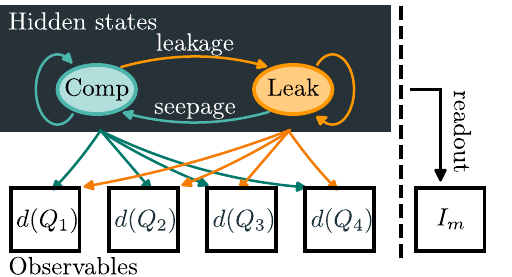
Fig. 4 Schematic representation of an HMM for leakage detec- tion. For both ancilla and data qubits only two hidden states are considered, corresponding to the qubit being either in the computational (teal) or leakage subspace (orange). Transitions between these states occur each QEC cycle, depending on the leakage and seepage probabilities. The state-dependent observa- bles are the defects d Q ð Þ on the neighboring stabilizers. For ancilla qubits, the in-phase component I m of the analog measurement is also used as an observable.